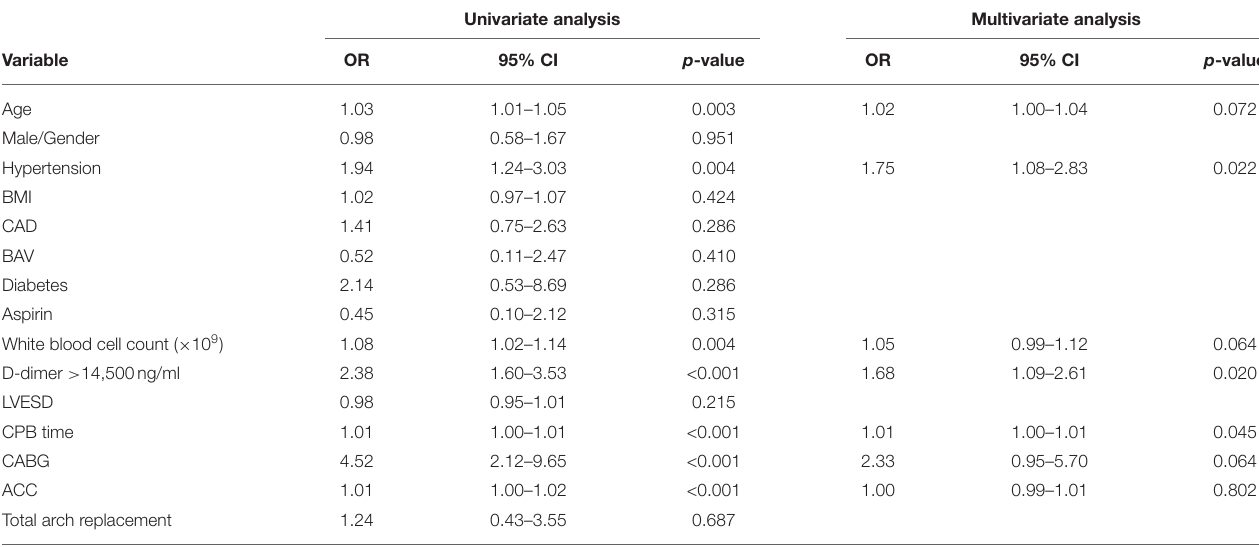
TABLE 4 | Univariate and multivariate analysis for MAE in patients with ATAAD. Univariate analysis Multivariate